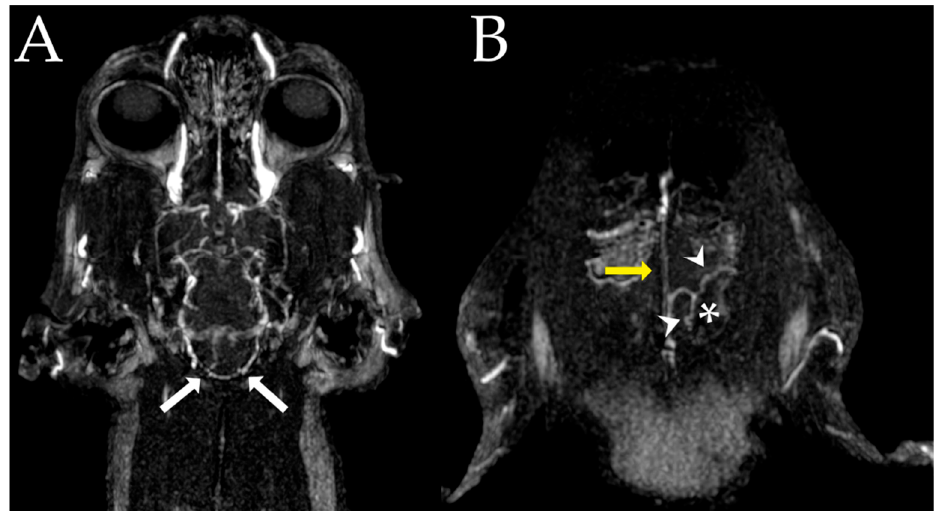
Figure 2. Advanced angiogram images. The patient was positioned in sternal recumbency. ( A ) On the axial view, the transverse sinuses (white arrows) are not affected by the mass. ( B ) The dorsal sagittal sinus is intact (yellow arrow) although the caudal meningeal vein (arrowheads) is observed as displaced by the mass effect exerted by the meningioma (asterisk) on the axial view. Bone data were obtained from the CT images and sliced into an STL file using 3D slicer software (3D Slicer, [www.slicer.org] accessed on 24 November 2021). With the